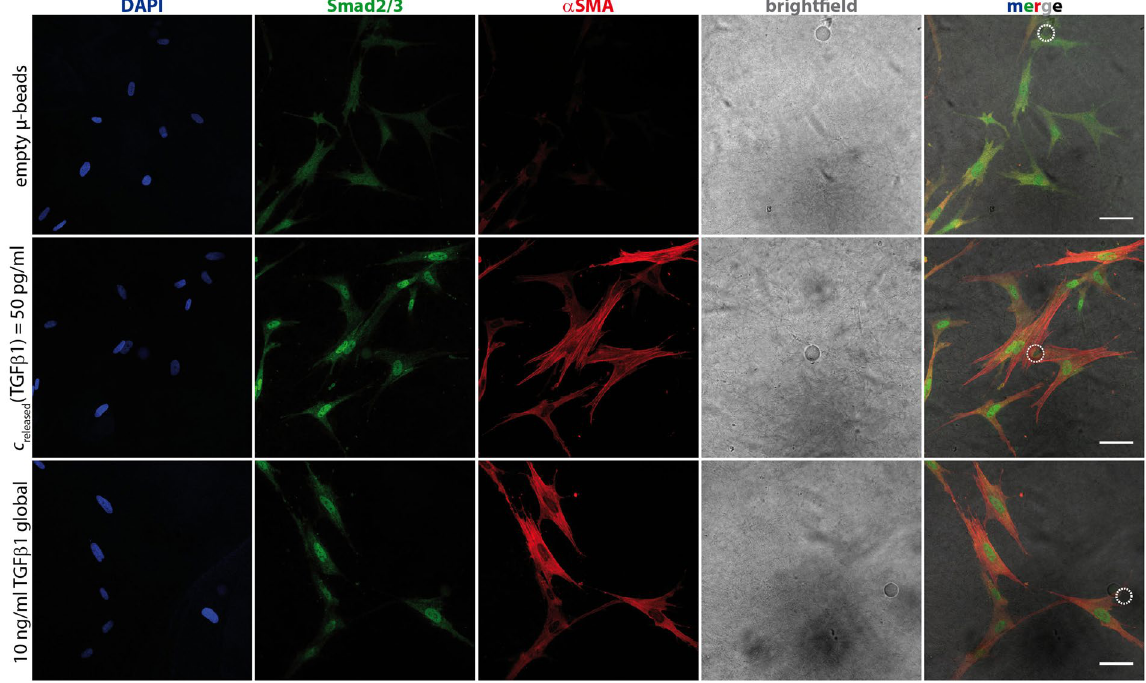
Figure 4. Nuclear Smad2/3 is expressed after stimulation with TGF β 1. Non-TGF β 1 stimulated fibroblasts (“empty beads”, upper row) exhibit only similar faint Smad2/3 staining in nucleus and cytosol. In comparison, TGF β 1 stimulated cells show strong nuclear Smad2/3. Correspondingly, actin stress fibers show α SMA staining in case of TGF β 1 stimulation. TGF β 1 delivery – whether 10 ng/ml systemic (lower row) or sustained local release of 55 pg/ml from µ -beads (middle row) – leads to comparable results. Scale bar: 50 µ m. White dashed circle in the merged images indicates µ -bead position.